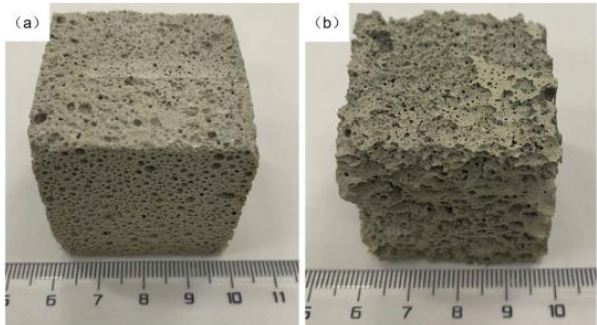
Figure 4. Air bubbles distributed in harden foamed concrete; with ( a ) ternary and ( b ) binary or without aerogels [168]. Reprinted with permission from publisher (2020) [168].